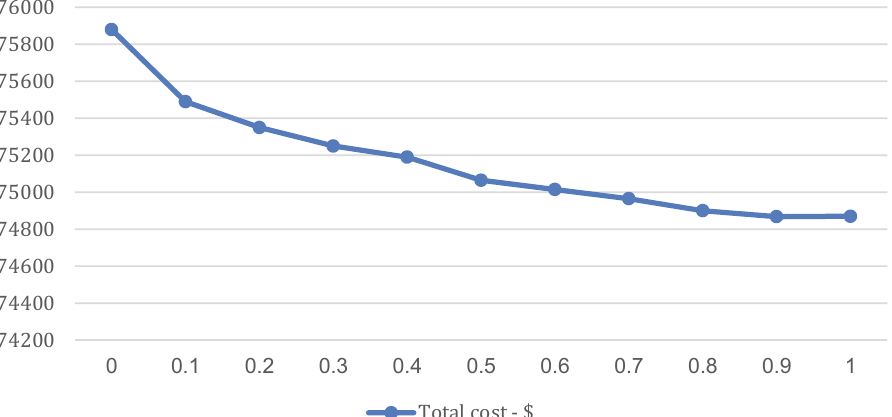
Fig. 8. Sensitivity of the proposed model to variations in robust